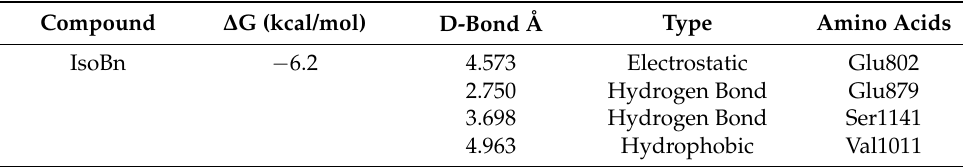
Table 5. Docking results of binding of IsoBn to active site of xanthine oxidase.